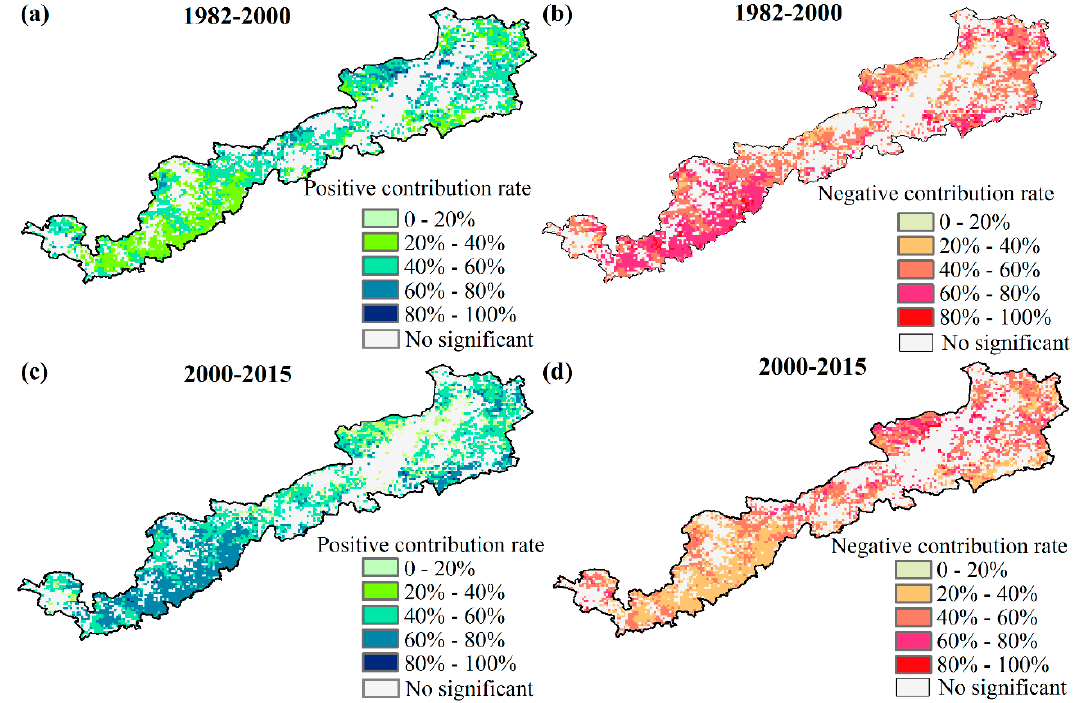
Figure 14. Spatial distribution of the positive (a and c) and negative (b and d) contribution rate to NDVI dynamics of human activities before and after 2000. Only pixels with P < 0.05 are presented.